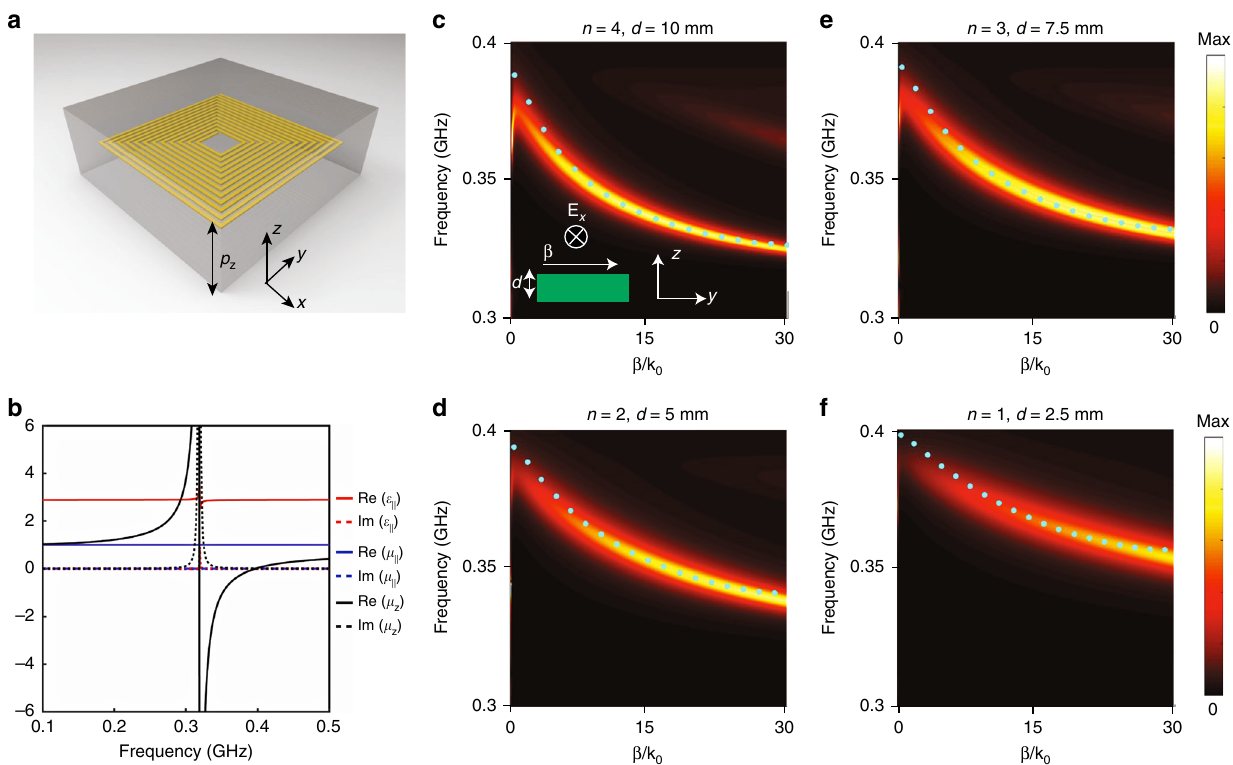
Fig. 2 From type-I hyperbolic metamaterials to type-I hyperbolic metasurfaces. a Scheme of the hyperbolic metamaterials composed of coiling copper wires. Here, p z = 5 mm; n = 12; p = 13.8 mm; w = g = 0.2 mm; and a = 2 mm. The coiling metal wires are embedded in a dielectric host with relative permittivity 2.55. b Retrieved constitutive parameters of the hyperbolic metamaterial. The hyperbolic region is from 0.315 to 0.4 GHz. ε ∥ , μ ∥ , and μ z are the in-plane permittivity, in-plane permeability, and out-of-plane relative permeability, respectively. c – f Dispersions of the metamaterial slabs with 4, 3, 2, and 1 layer, respectively. The green dots are the dispersion of the practical metamaterial structures. The false-color plots are the dispersion relations of the metamaterial slabs with the retrieval constitutive parameters. Here, d is the effective thickness of the metamaterial